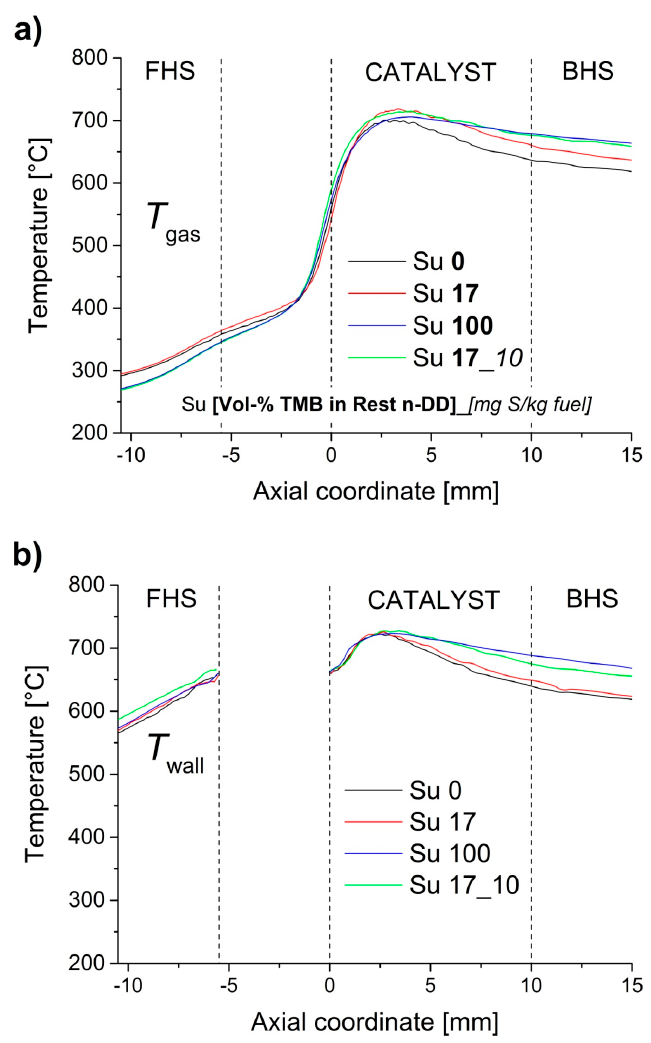
Figure 2. Gas-phase ( a ) and surface ( b ) temperature profile for the CPOX of fuel Su 17 as function of the axial coordinate z for the Rh catalyst ( z = 0–10 mm). For the gas-phase temperature T gas , the moving average for five points is displayed. Along the axial coordinate, the location of the front heat shield (FHS), the catalyst, and the back heat shield (BHS) is indicated.